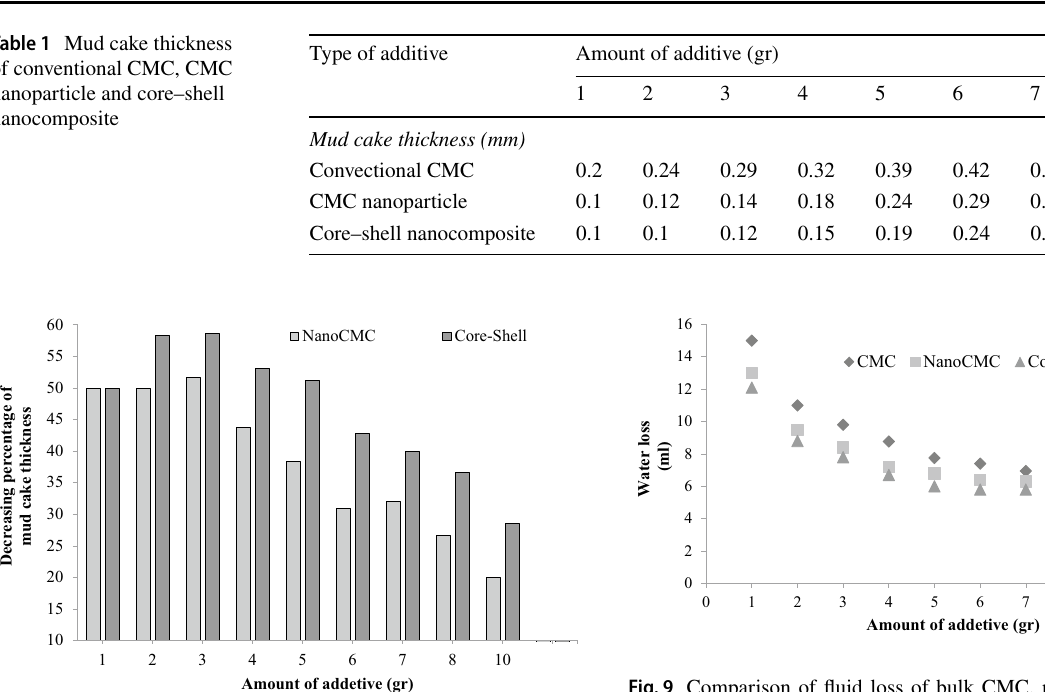
Fig. 9 Comparison of fluid loss of bulk CMC, nanoCMC and